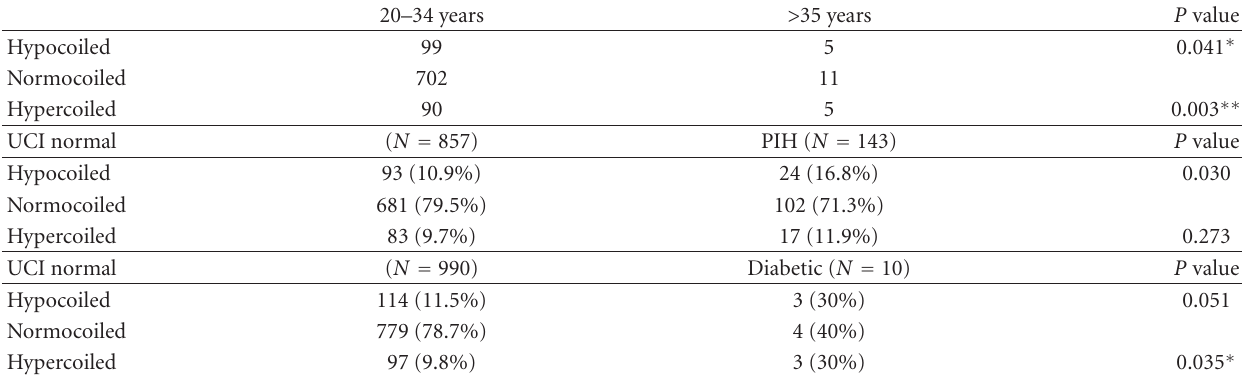
Table 2: Distribution frequencies of the three groups according to the maternal